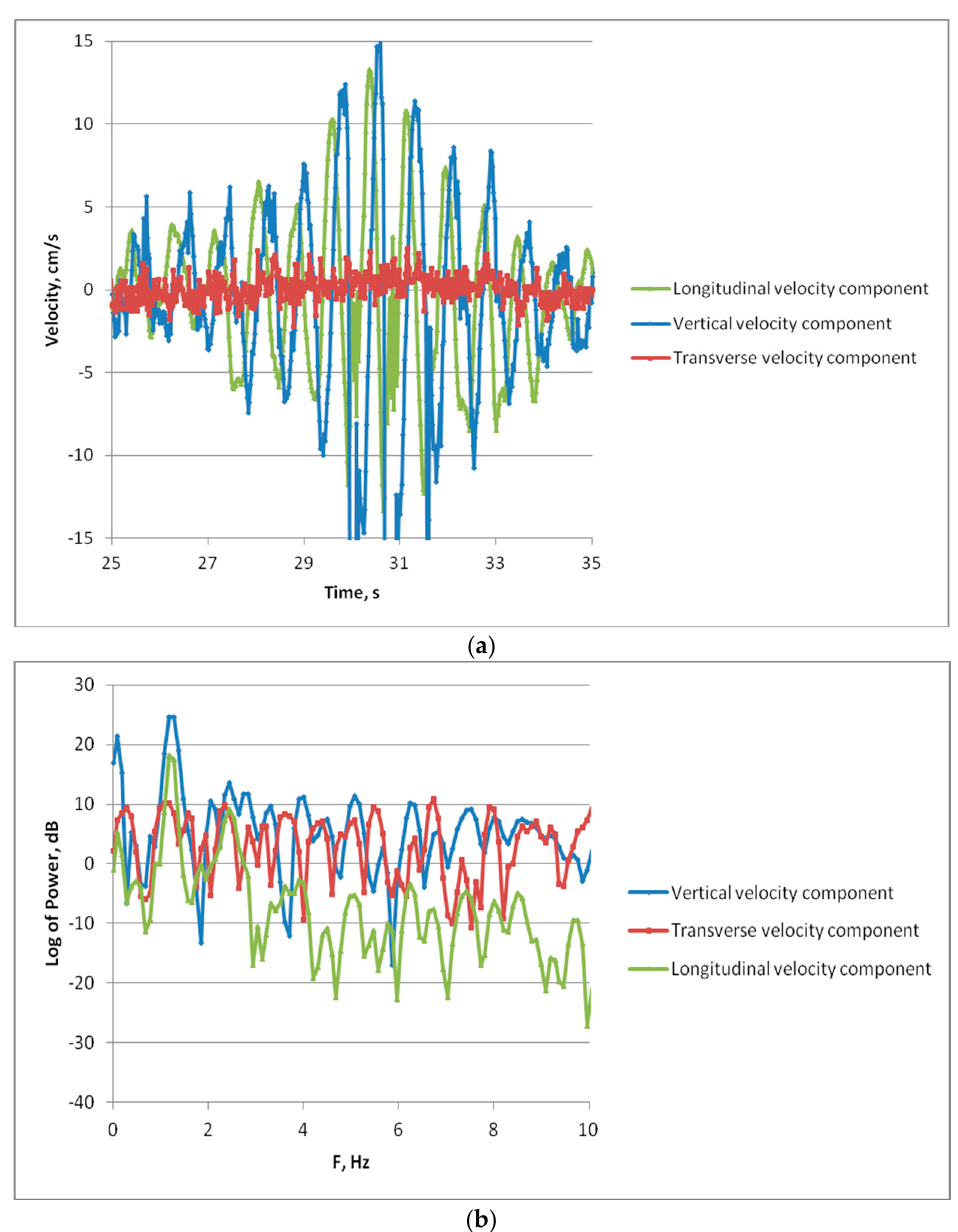
Figure 4. Time records of longitudinal, vertical and transverse orbital velocity components for a wave train of LF nonbreaking waves with a frequency of 1.2 Hz and an amplitude of 2.3 cm measured with ADV ( a ) and Fourier spectra ( b ) of these components.